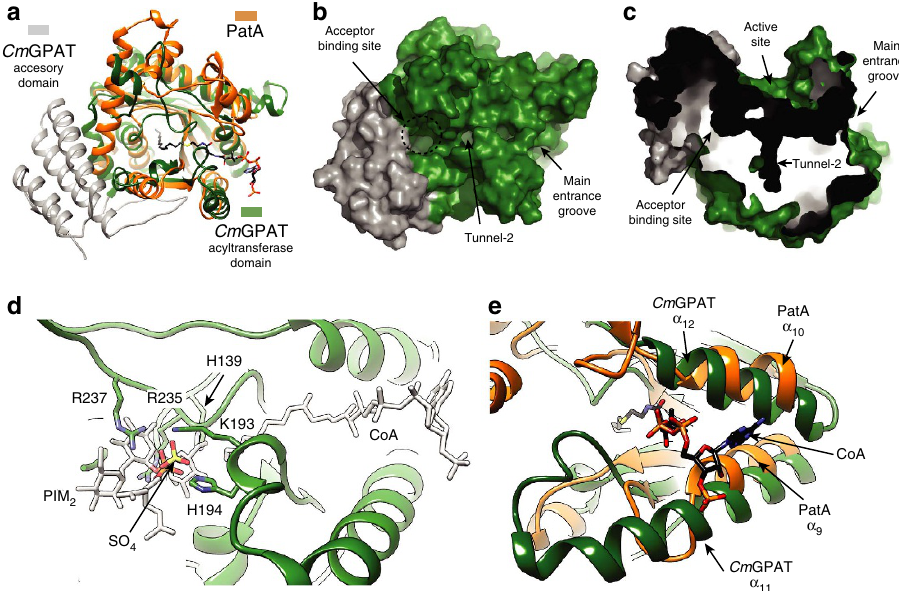
Figure 7 | Structural similarities between PatA and Cm GPAT. ( a ) Structural superposition of PatA and Cm GPAT. Secondary structure elements are labelled. The localization of the fatty acid and acceptor binding sites in Cm GPATare indicated. ( b , c ) The active site of Cm GPAT is located into a main groove, with a hydrophobic tunnel running perpendicular and deeply buried into the core of the enzyme. ( d ) Structural superposition of the proposed acceptor binding site in PatA and Cm GPAT, showing donor and acceptor PatA substrates for spatial reference in white colour. ( e ) Structural superposition of the CoA binding site in PatA and Cm GPAT.